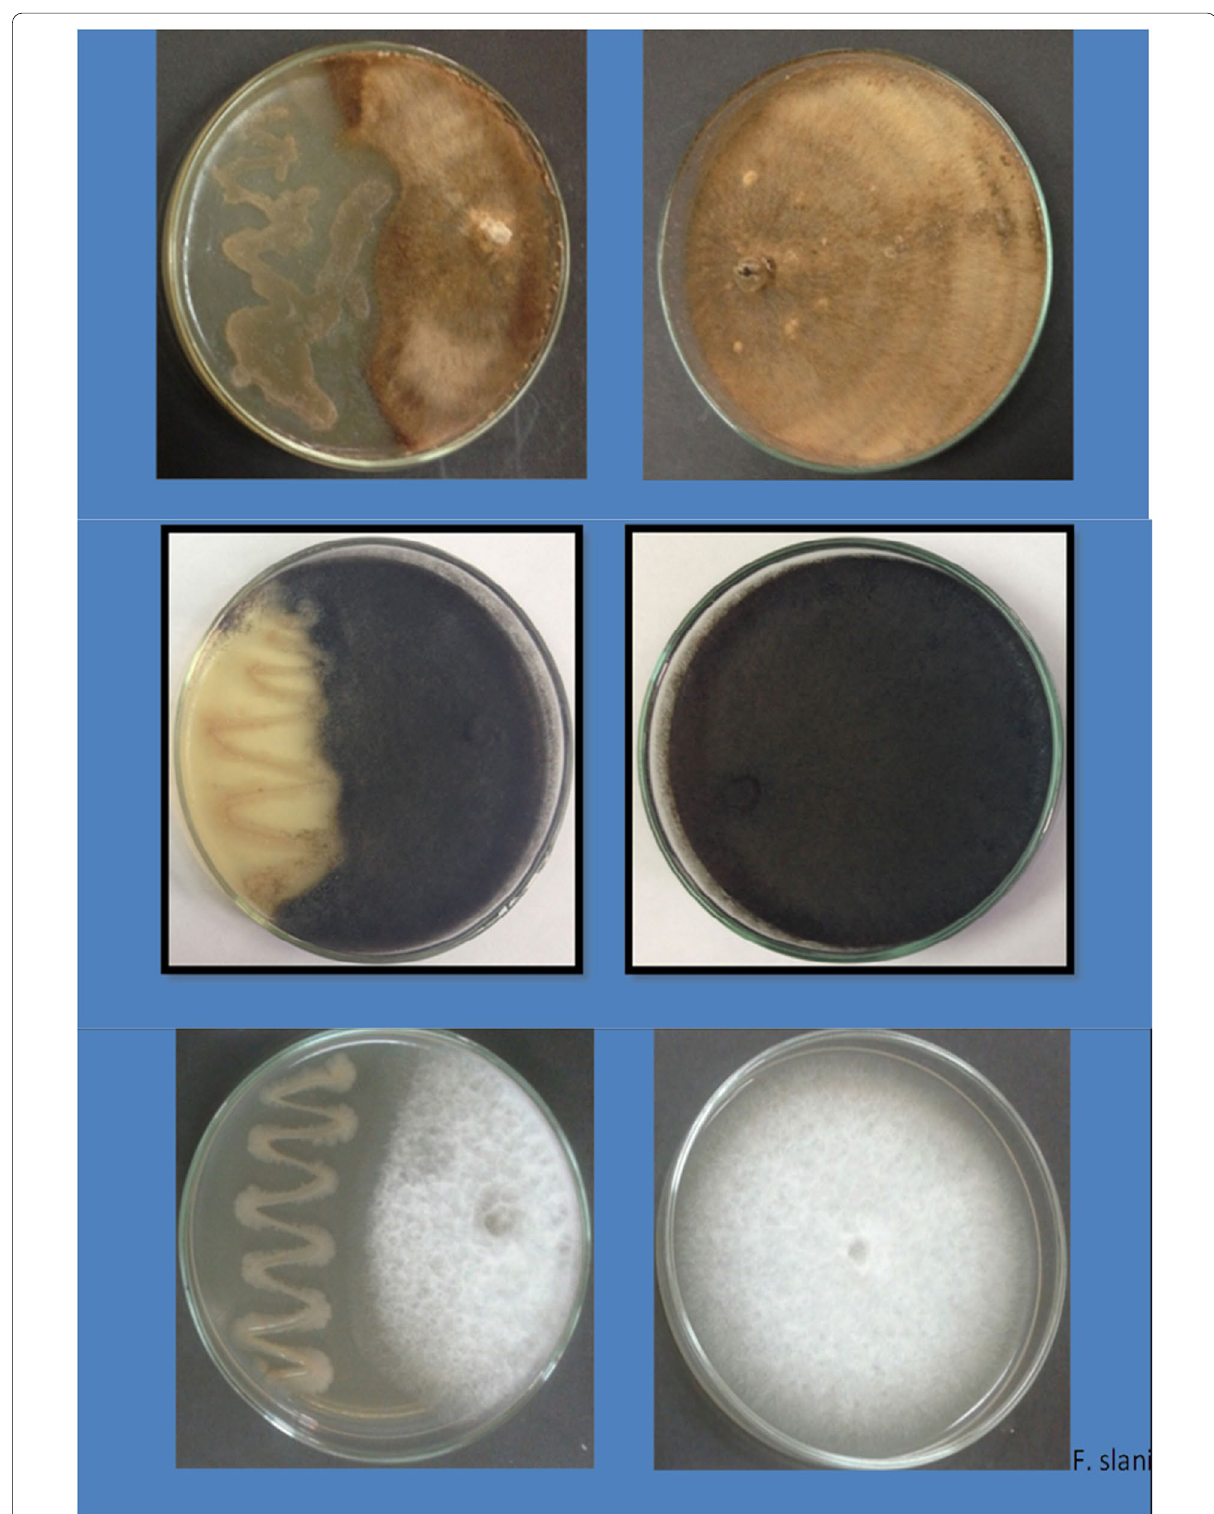
Fig. 1 Effect of Bacillus brevis isolate 2 on growth area of the pathogenic fungi Rhizoctonia solani (upper dishes), Macrophomina phaseolina (Medium dishes), and Fusarium solani (lower